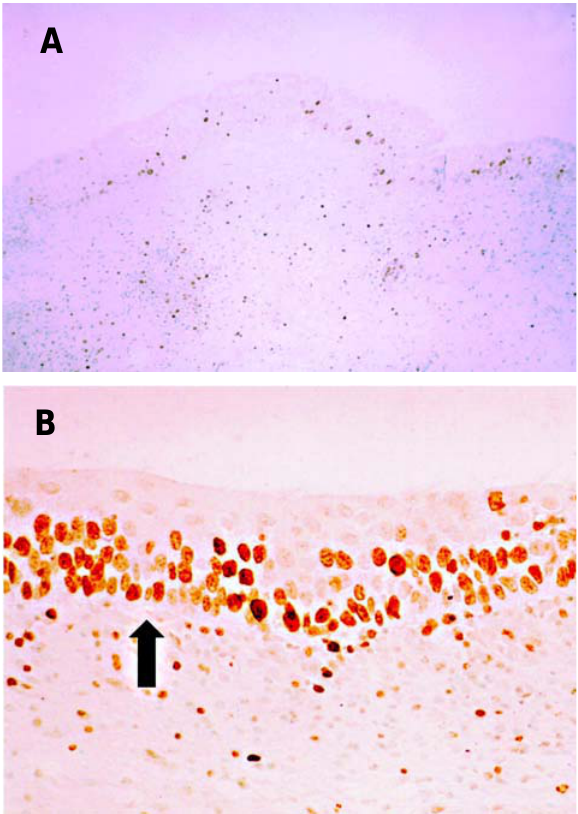
Figure 5 – Histological section of rabbit bladder immunohis- tochemical staining (KI 67 antibodies), X400. A) Control group - G1. B) Intense epithelial hyperplasia (arrow) in group G2,